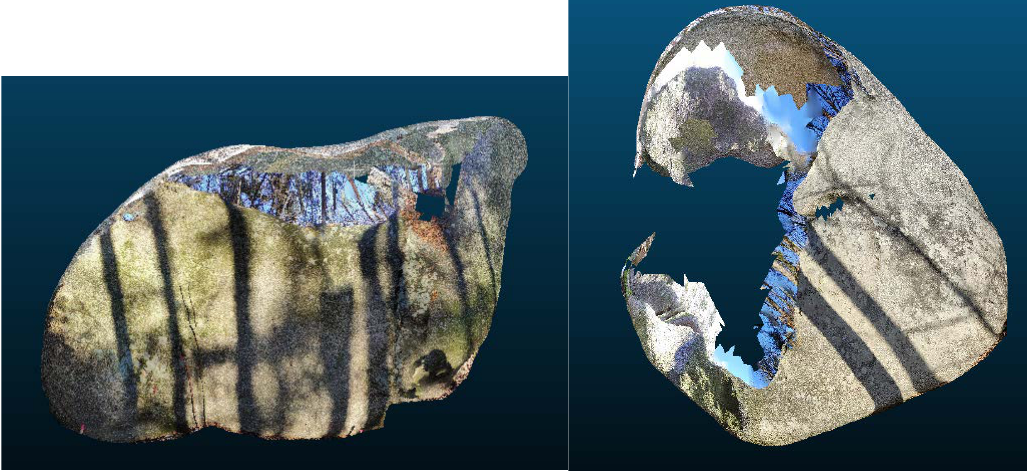
Figure 8. Models from SCANN3D App (Boulder No.1 – left, boulder No.2 – right).